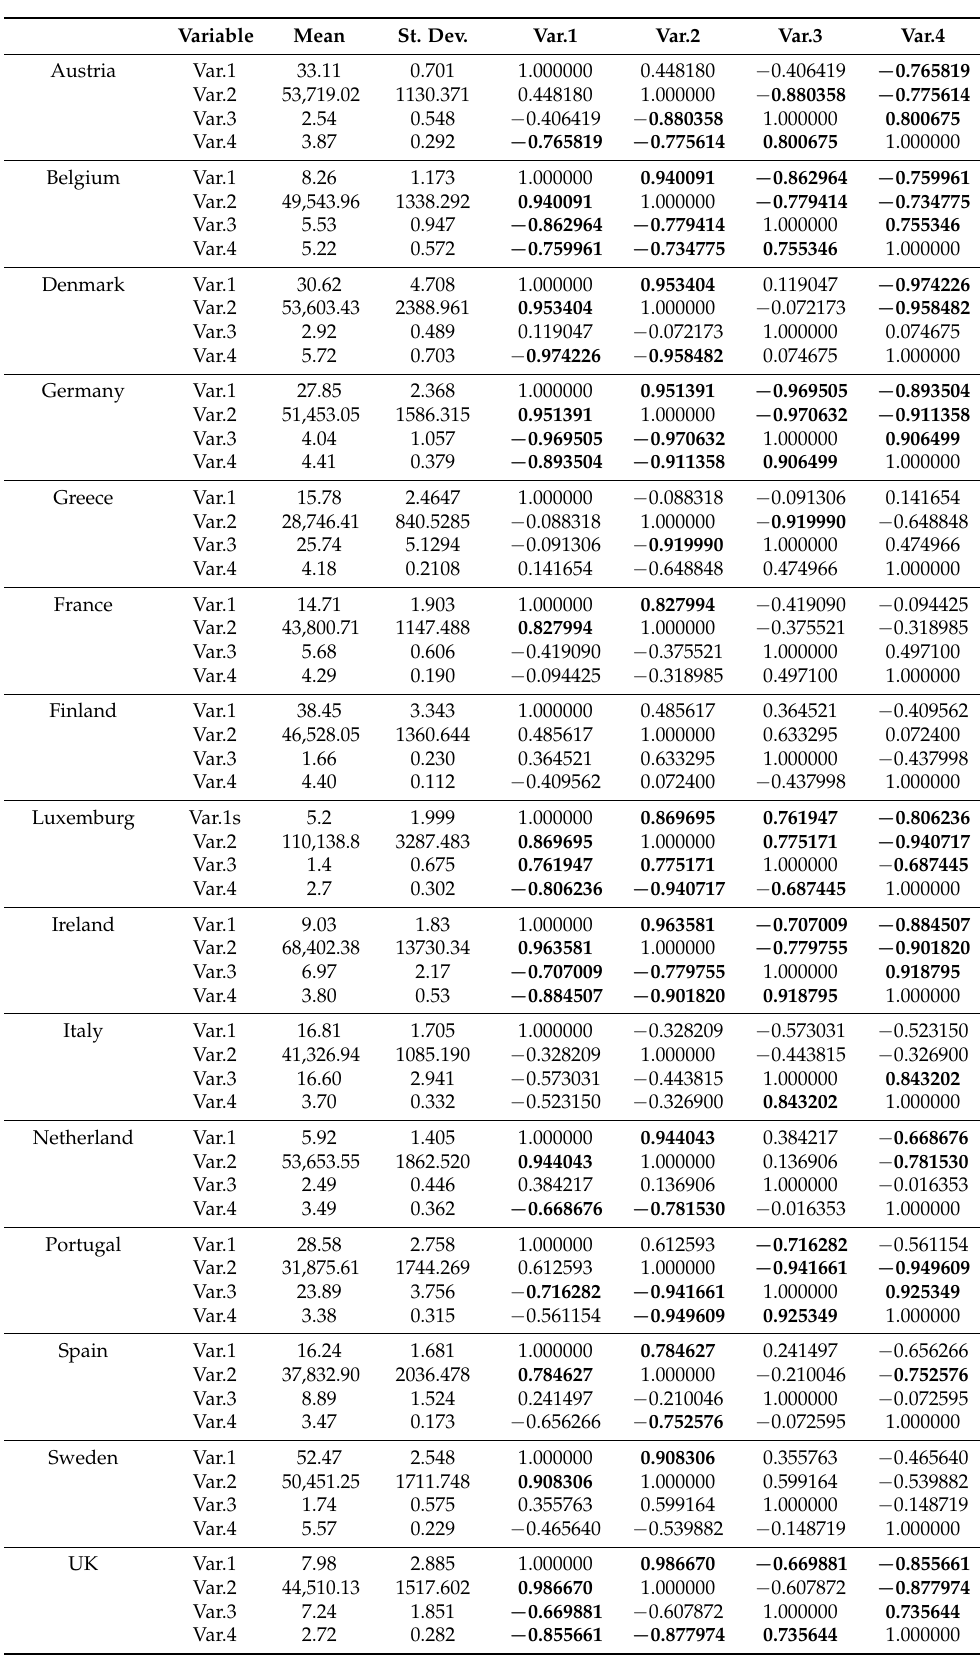
Table 8. Correlation